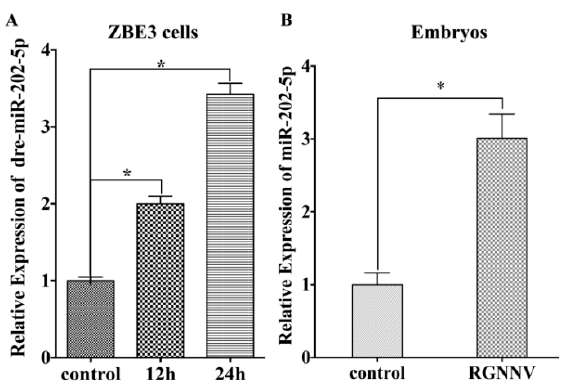
Figure 1. miR-202-5p is upregulated in zebrafish during red spotted grouper nervous necrosis virus (RGNNV) infection. ( A ) ZBE3 cells were infected with RGNNV for di ff erent periods. ( B ) Zebrafish embryos were infected with RGNNV for 24 h. The expression of miR-202-5p was tested by qRT-PCR. The relative expression of miR-202-5p was normalized with 18s rRNA and represented as fold induction relative to the transcription level in the control, which was regarded as 1. Asterisks indicate the significant di ff erences between groups (*: p < 0.05).